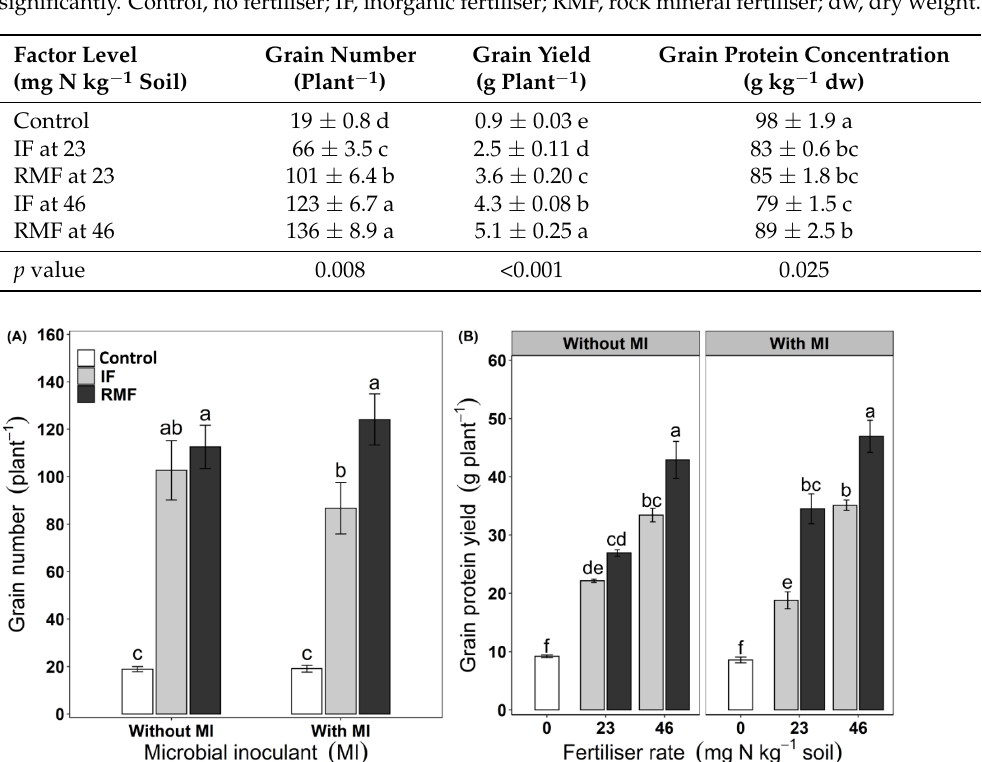
Table 4. Grain number, yield and protein concentration as influenced by the interaction effect of fertiliser type (Ft) and fertiliser rate (Fr). Three-way ANOVA (Table 3) showed significant interaction effect of Ft × Fr (mean ± SE, n = 8). Means within a column followed by different letters differ significantly. Control, no fertiliser; IF, inorganic fertiliser; RMF, rock mineral fertiliser; dw, dry weight.